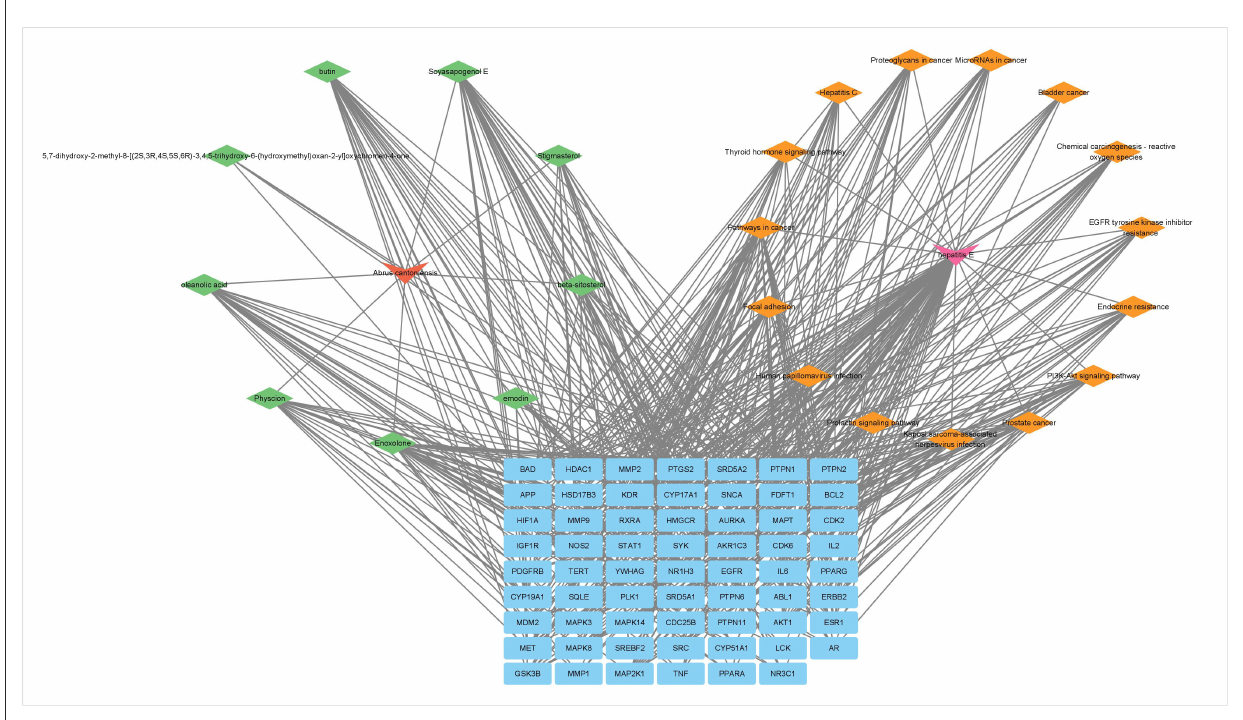
FIGURE4 Drug-active ingredient-disease-pathway-target network.